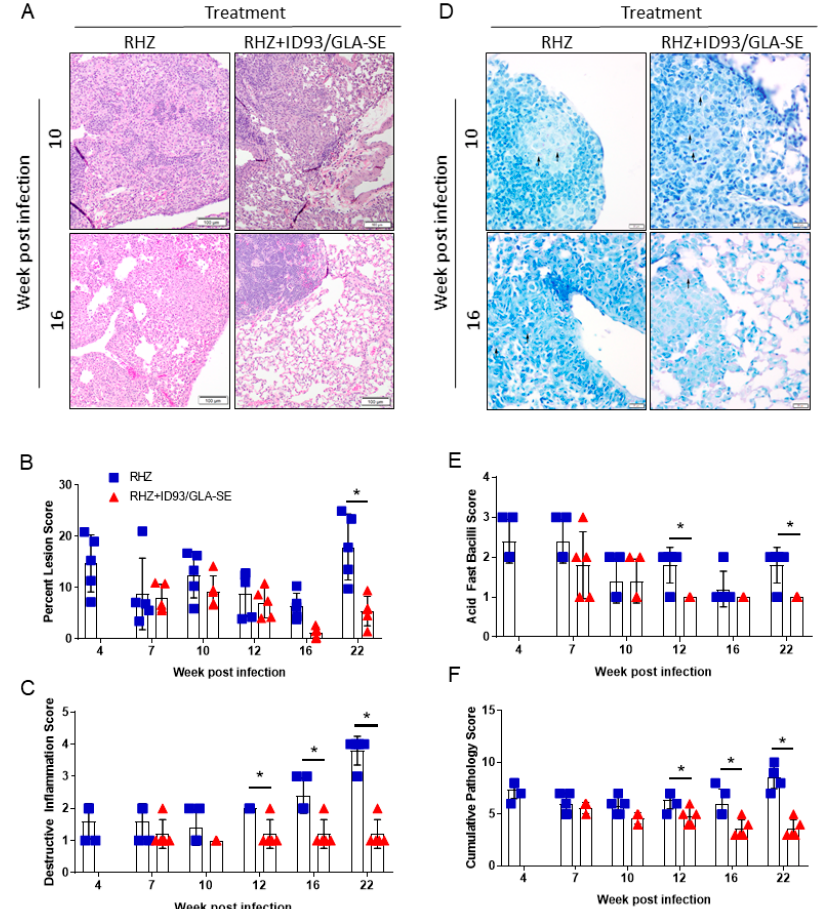
Figure 3. Decreased pathology with combined antibiotic and immunotherapy. ( A ) Representative H and E histological images from RHZ treated and RHZ+ID93/GLA-SE treated cohorts at 10 (upper) and 16 (lower) weeks post Mtb challenge. ( B ) Percent lesion area (mean ± SEM). ( C ) Destructive Inflammation score. ( D ) Representative acid-fast strained histological images from RHZ treated and RHZ+ID93/GLA-SE treated cohorts at 10 (upper) and 16 (lower) weeks post Mtb challenge. Acid-fast bacilli (AFB) are denoted by arrows. ( E ) AFB score and ( F ) cumulative pathology score of lung histology over time. Histological results are representative of two independent experiments. All data were evaluated using two-way ANOVA and Sidak’s correction for multiple comparison. The asterisk denotes significance where p <